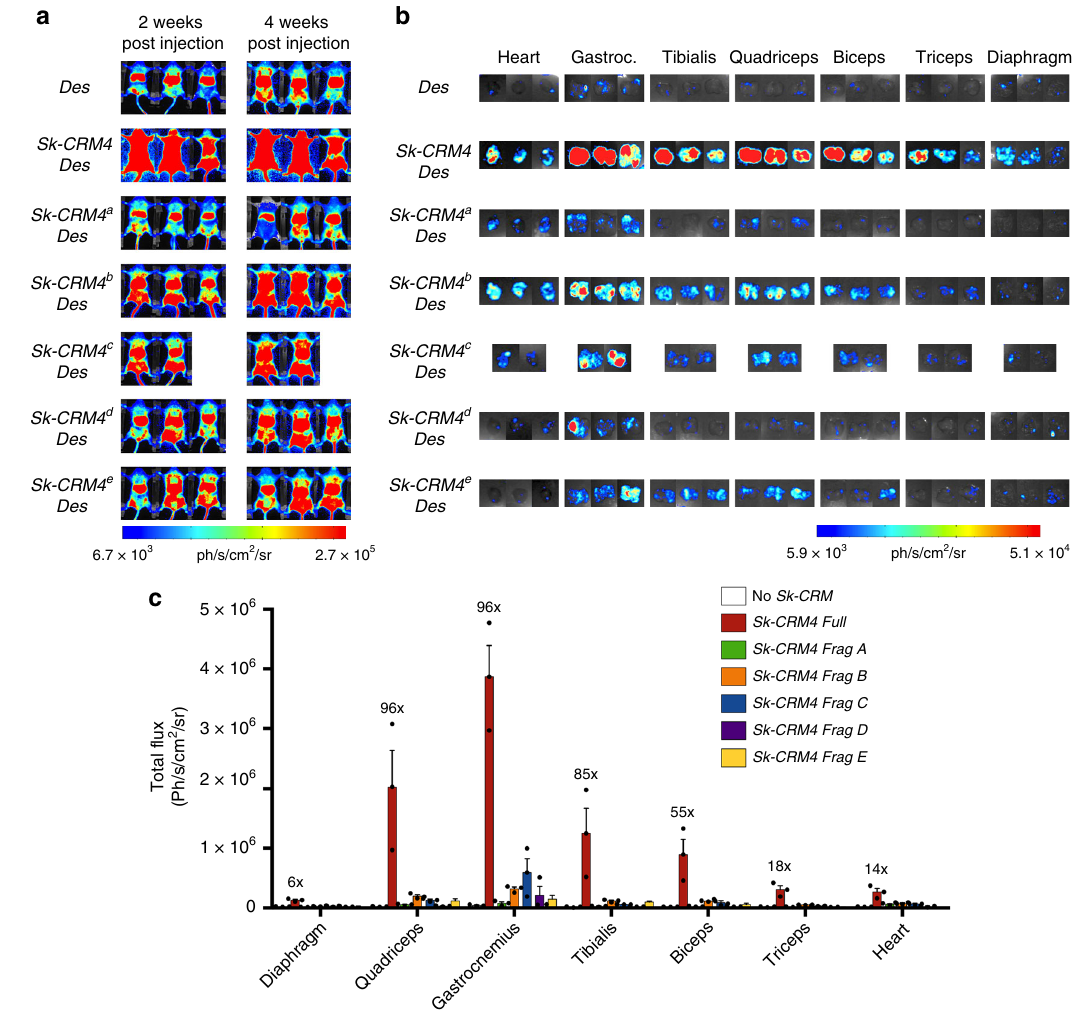
Fig. 3 Screening and validation of Sk-CRM4 fragments. a In vivo bioluminescence imaging at week 2 and week 4 post vector injection and quanti fi cation of luciferase expression from the different individual organs of adult CB17/IcrTac/Prkdc scid mice injected intravenously with scAAV9-Des-Luc2 (control, no Sk-CRM ), scAAV9-Sk-CRM4 a -Des-Luc, scAAV9-Sk-CRM4 b -Des-Luc, scAAV9-Sk-CRM c -Des-Luc, scAAV9-Sk-CRM4 d -Des-Luc, and scAAV9-Sk-CRM4 e - Des-Luc vectors at a dose of 1 × 10 10 vg per mouse. The corresponding color scale from 6.70e + 03 (blue) ph/s/cm 2 /sr to 2.70e + 05 (red) ph/s/cm 2 /sr was shown. Photon emission was measured dynamically during 7 min in a supine position. b Ex vivo bioluminescence imaging of individual organs such as the heart and the different muscle groups harvested at 6 weeks post vector injection was represented on a color scale with luciferase intensities ranging from 5.92e + 03 (blue) ph/s/cm 2 /sr to 5.08e + 04 (red) ph/s/cm 2 /sr. The bioluminescence signal was quanti fi ed for 5 min. c Luciferase expression from the individual tissues was measured as total fl ux, expressed in photons/sec/cm 2 /sr. The fold-difference of the total fl ux was indicated for each Sk-CRM4 fragments relative to that of the control group containing the Des promoter without any Sk-CRM . The total fl ux data were displayed as mean + s.e.m. ( n